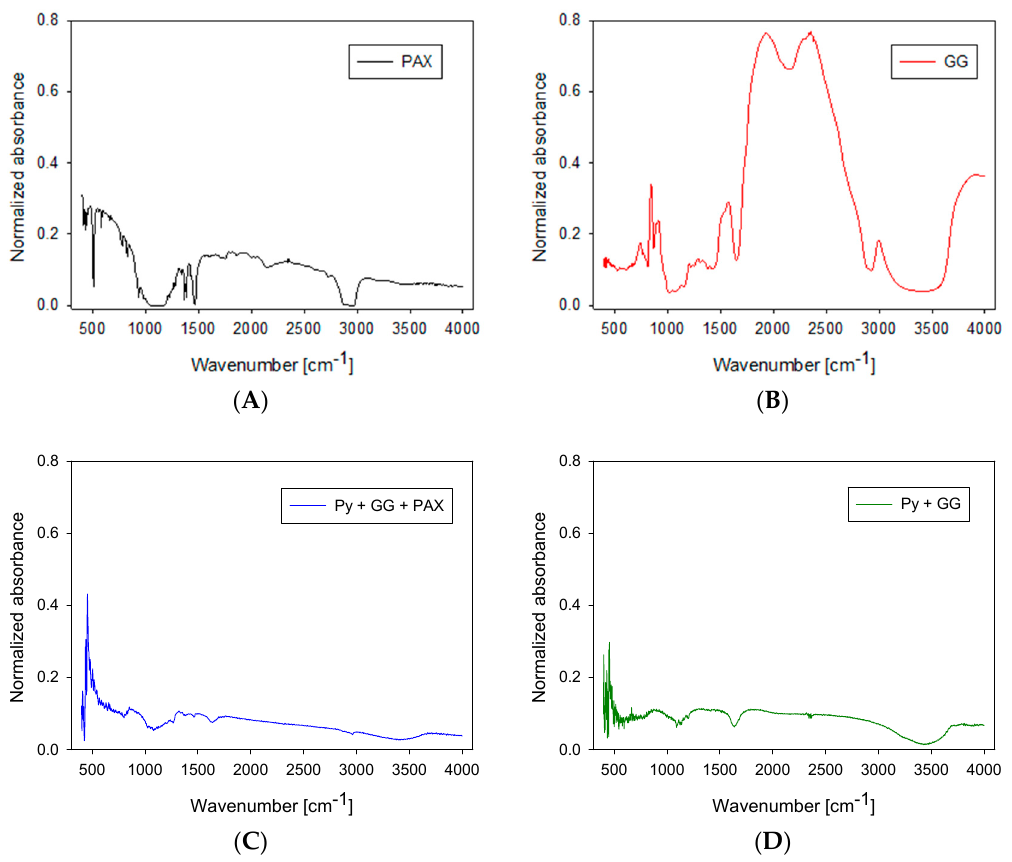
Figure 14. FTIR spectra for ( A ) PAX, ( B ) guar gum (GG), ( C ) pyrite (Py) + GG + PAX, and ( D ) Py + GG (pH 8, 35 ppm of PAX, 20 ppm of guar gum).